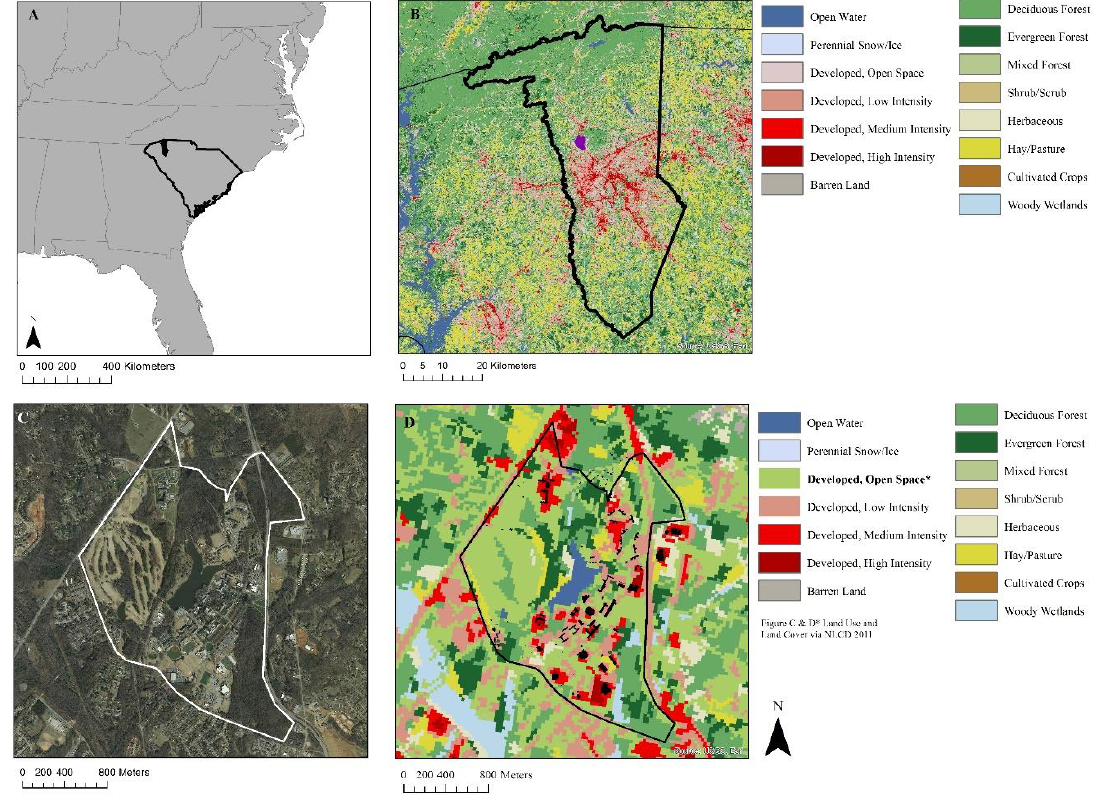
Figure 1. ( A ) Location of the study area (university) in the Southeastern USA with Greenville County in solid black, ( B ) Land use and land cover classification from the National Land Cover Database (NLCD 2011) for Greenville, SC, USA (black outline); purple polygon represents Furman University campus, ( C ) Aerial image of the campus (white outline), and, ( D ) campus scale NLCD 2011 image modified to show areas with <49% impervious surface (e.g., a golf course) as green space.